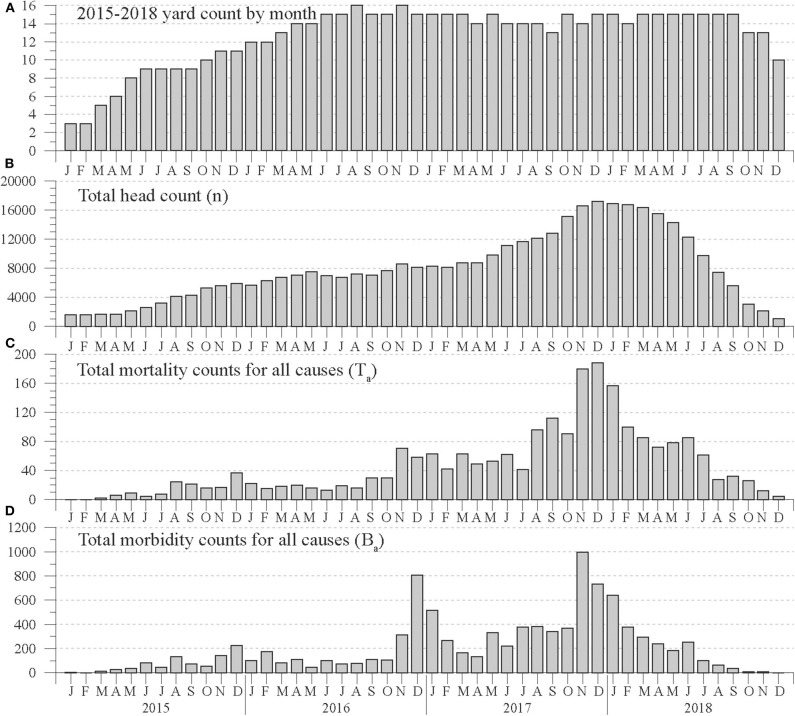
Monthly counts of (A) feedyards reporting population, mortality, and morbidity data, (B) estimated total head on feed, (C) total mortality, and (D) total morbidity counts for cattle within a 96.6-km radius of Hereford, TX, in the Texas Panhandle from January 2015 to December 2018.